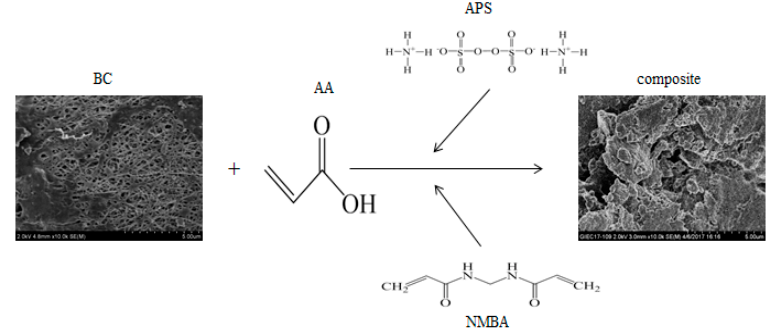
Figure 1. Reaction scheme for cellulose-based absorbent production.